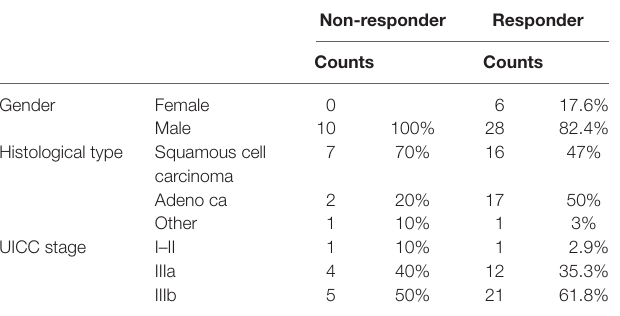
Table 2 | Clinico-pathological characteristics of non-responding and responding non-small-cell lung cancer patients at M0 (Martin Luther University Hospital,